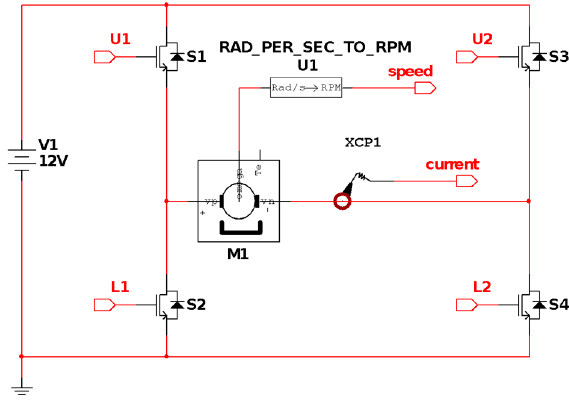
Figure 2. DC Motor and H bridge topology in Multisim.